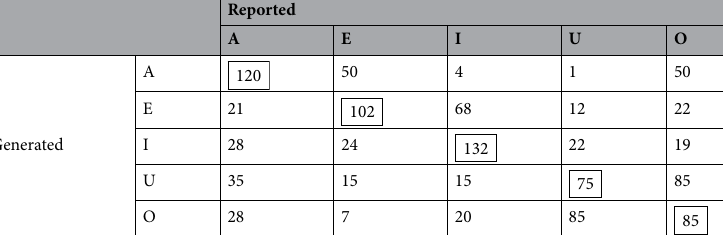
Table 1, translated to percentages of correct guess, gives the values: A : 53%, E : 45%, I : 59%, U : 33%, O : 38% . To better understand how each synthetic vowel set is mapped to the reported vowel labels at the different pitches, a sequence of scatterplots is reported in Fig. 4 (left). In each scatterplot, the horizontal axis represents the synthetic vowel set and the vertical axis is quantized to the five reported vowels. To reduce visual overlap, a zero-mean 0.05-std gaussian jitter has been added, and individual responses have been rendered as tiny black dots with 80% transparency. The background has been colored with a 7-values Viridis colormap to represent a bivariate kernel density estimate on a grid of 151 × 151 points, as computed by the kde function of the R package ks , with default parameters. Red circles highlight the areas where a denser distribution of points is expected in case of good matching between generated and perceived vowels. Each individual scatterplot reports the meas- ured accuracy at the corresponding pitch, that is the number of correct labels divided by the total number of stimuli, aggregated on vowels, and expressed as a percentage. An aggregation of results in the three ranges of the